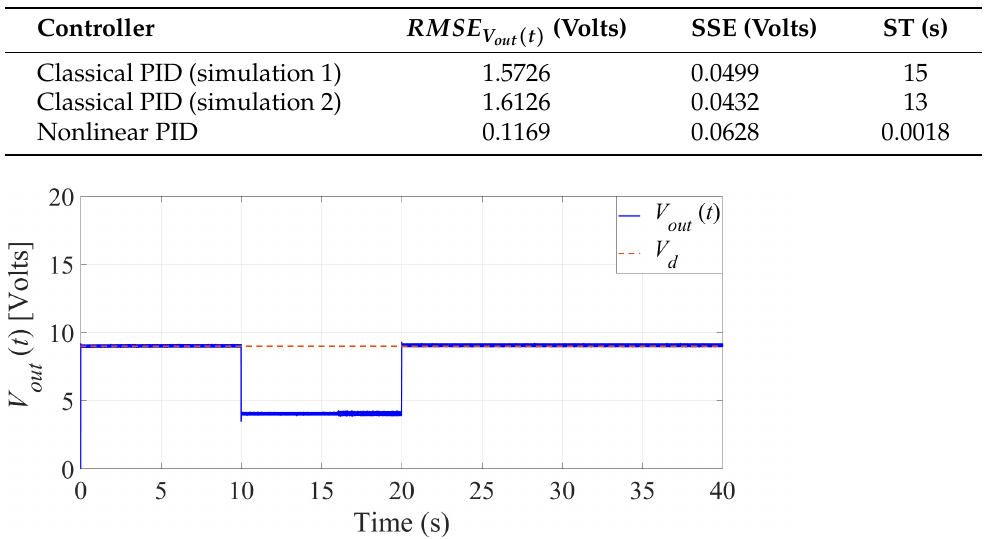
Table 5. System performance for 20 < t in scenario 2.